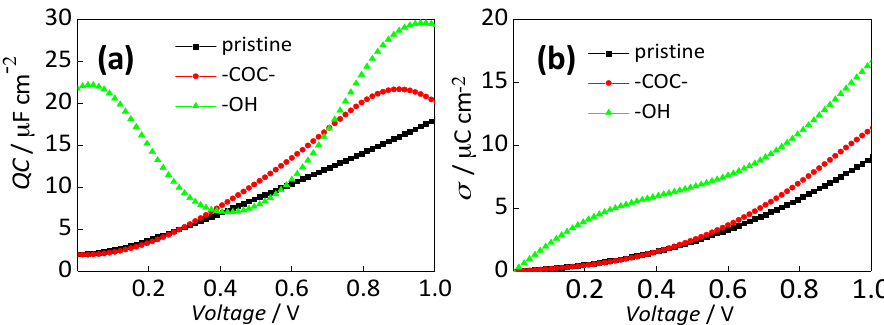
Figure 8. Energy storage performance of graphene with different residue oxygen. ( a ) quantum capacitance (QC) and ( b ) excessive surface charge density (ESCD).